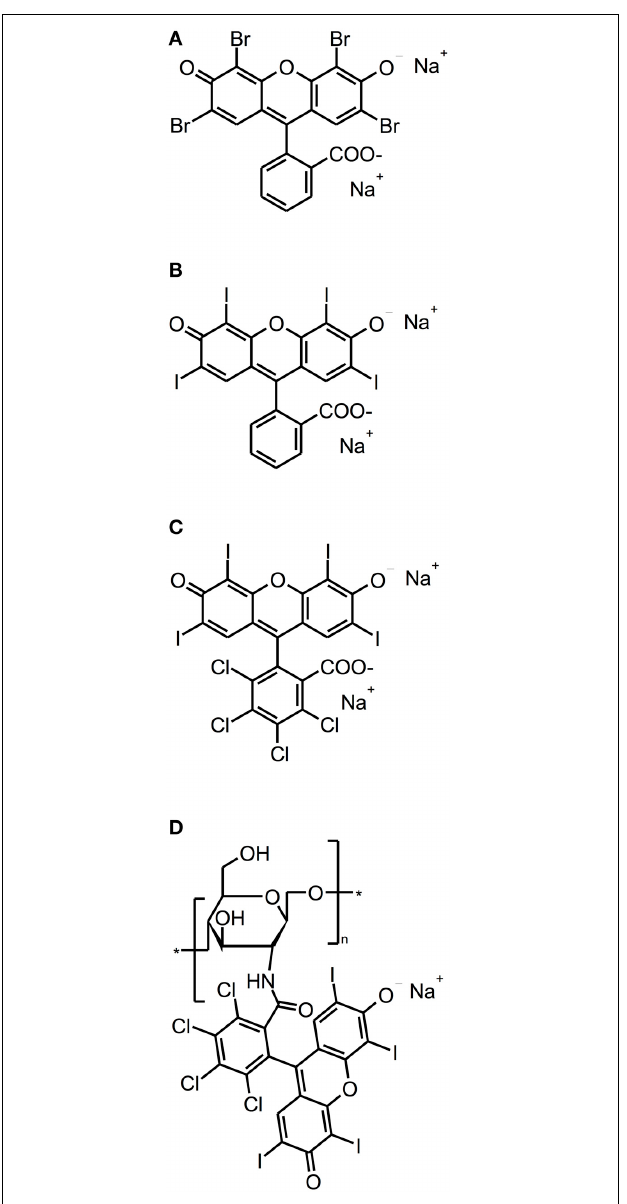
FIGURE 4 | Fluorescein derivatives. Chemical structures of fluorescein derivatives: (A) Eosin Y. (B) Erythrosine. (C) Rose Bengal. (D) Chitosan-conjugated Rose